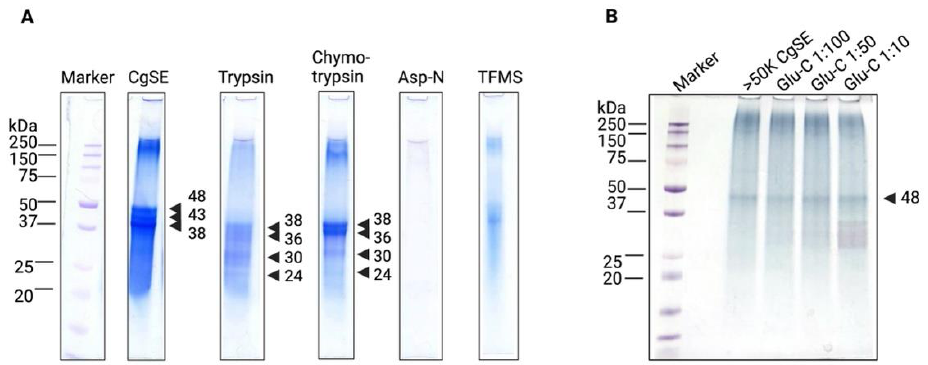
Figure 4. SDS-PAGE profiles of CgSE and >50K CgSE-protease and chemically deglycosylated treated samples. ( A ) Forty µ g of CgSE was treated with various endoproteinase enzymes and stained with Stains-all. ( B ) Ten µ g of >50K CgSE was treated with Glu-C Endoproteinase under different enzyme-to-protein ratios and stained with Stains-all. Abbreviation: CgSE, Crassostrea gigas shell EDTA extract; TFMS, Trifluoromethanesulfonic acid. This figure was created using BioRender.com (accessed on 25 July 2022).